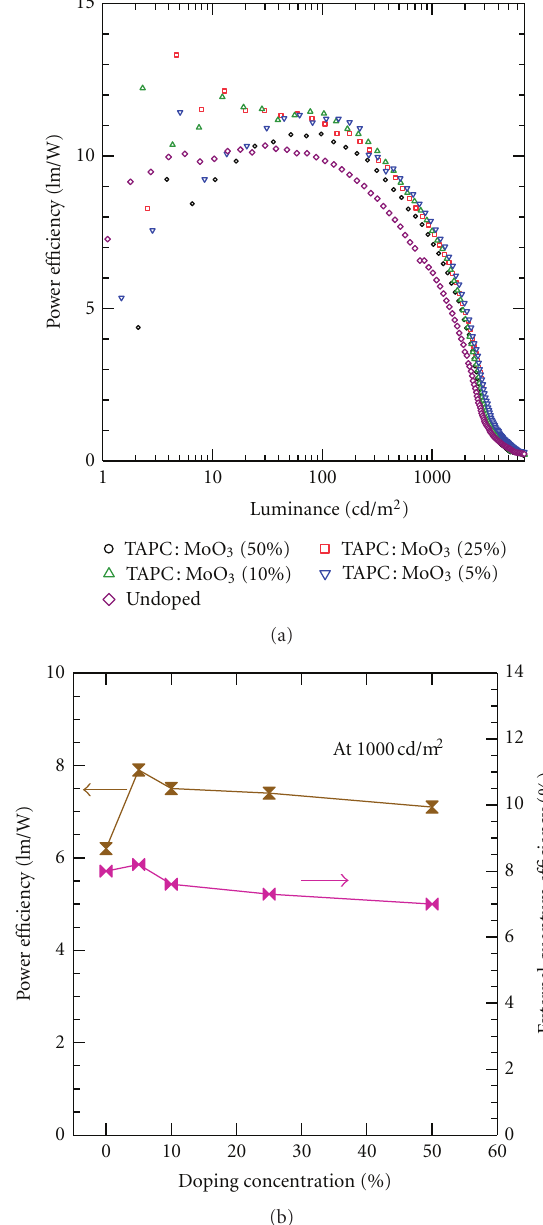
Figure 5: (a) Power e ffi ciency versus luminance characteristics and (b) power e ffi ciency and external quantum e ffi ciency of WOLEDs at 1,000 cd · m − 2 with di ff erent MoO 3 doping